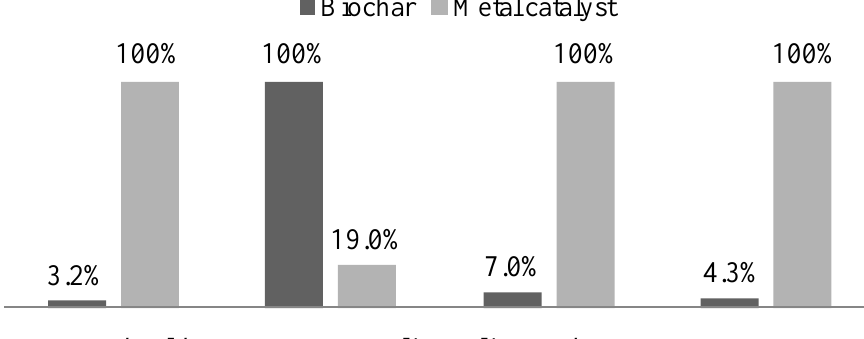
Figure 4. Comparison of damage assessment.